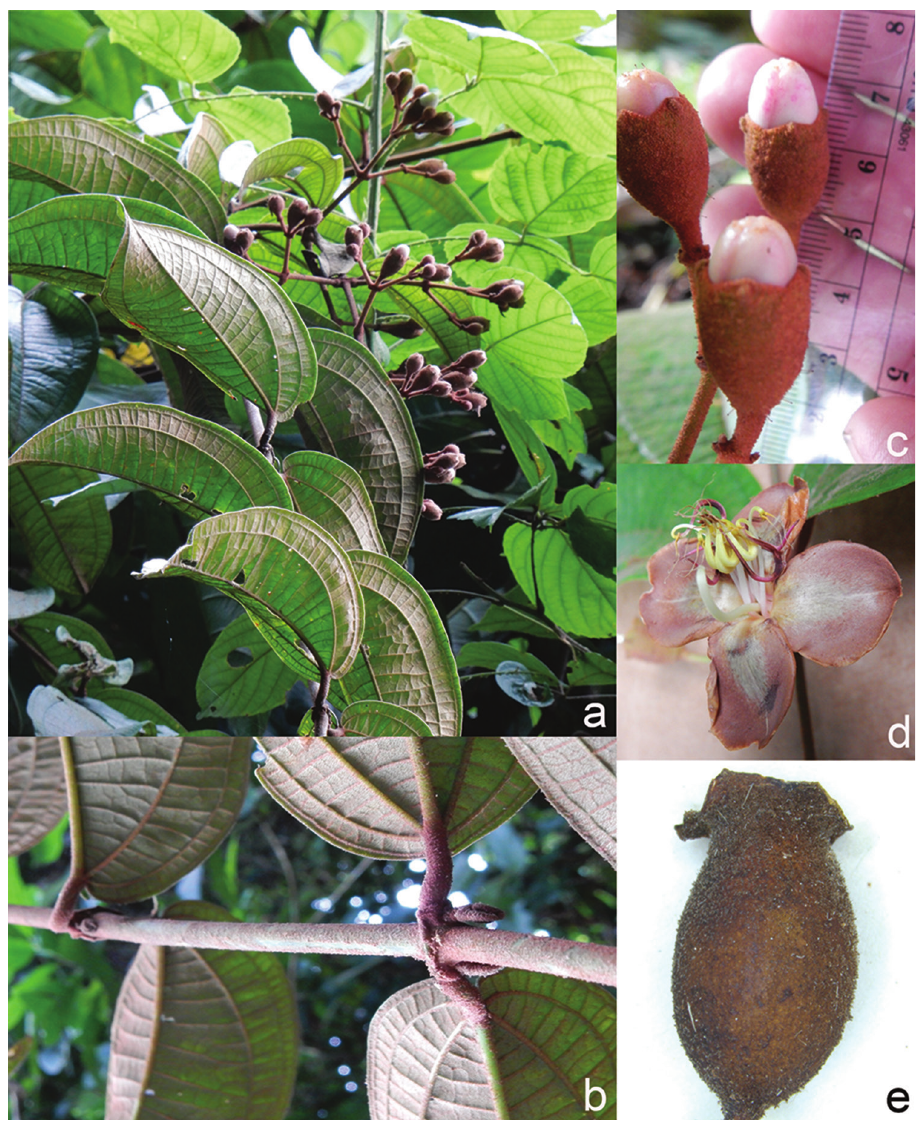
Figure 5. Dissochaeta annulata a habit b branchlet c hypanthium d flower e fruit. Photographs by D. Penneys, vouchers: Penneys 2506